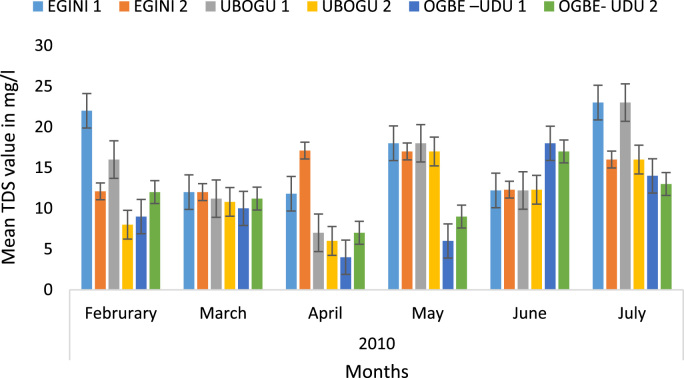
Mean Temporal and spatial variations in Total Dissolved Solid (TDS).